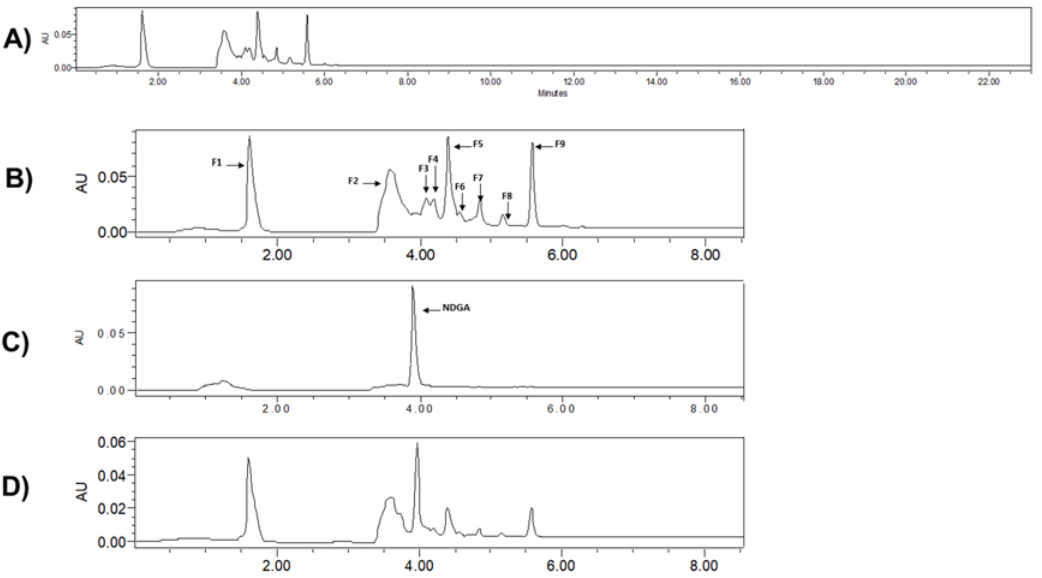
Figure 9. Chromatograms obtained for: ( A ) Larrea tridentata (LT)-ethanol: water extract alone at 24 min; ( B ) zoom in of Larrea tridentata (LT)-ethanol: fractions alone; ( C ) zoom in of nordihydroguaiaretic acid (NDGA) alone and ( D ) zoom in of mixture of LT-ethanol: water extract and NDGA as pure compound, detection at 280 nm. The fractions collected are numbered (F1–F9) as indicated.